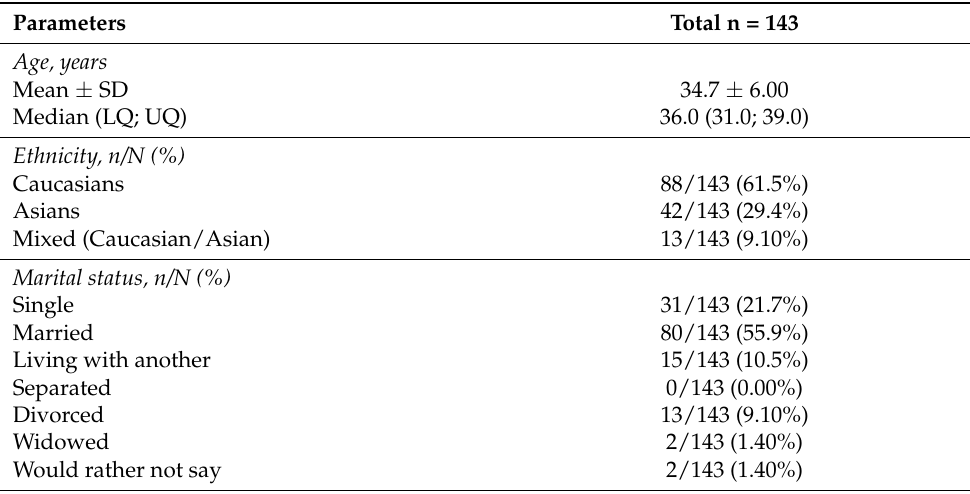
Table 1. Socio-demographic characteristics of healthy